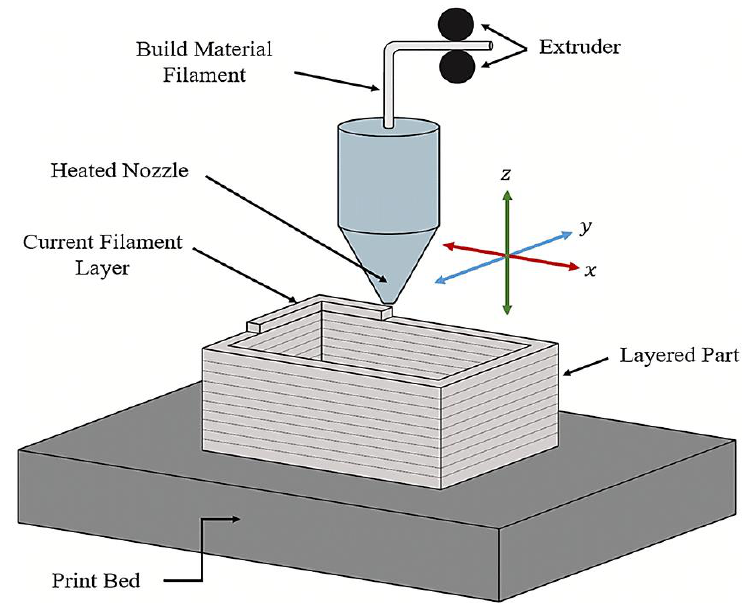
Figure 1. Overview of the FDM process.